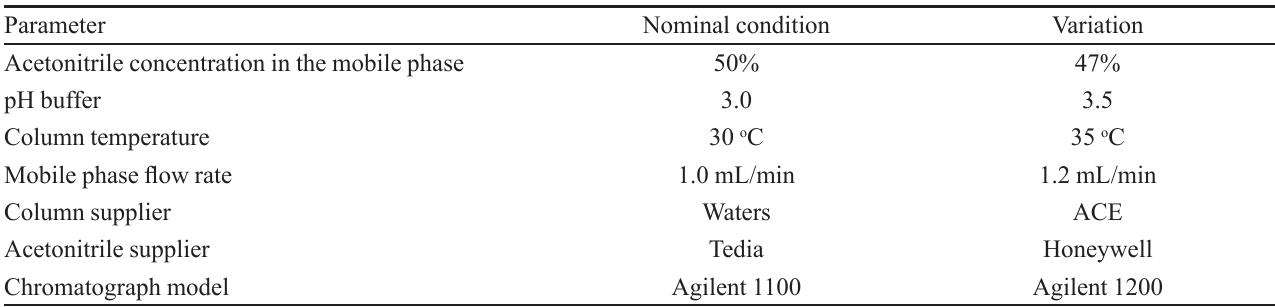
TABLE I - Analytical parameters and variations for the robustness evaluation of the chromatographic method for simultaneous